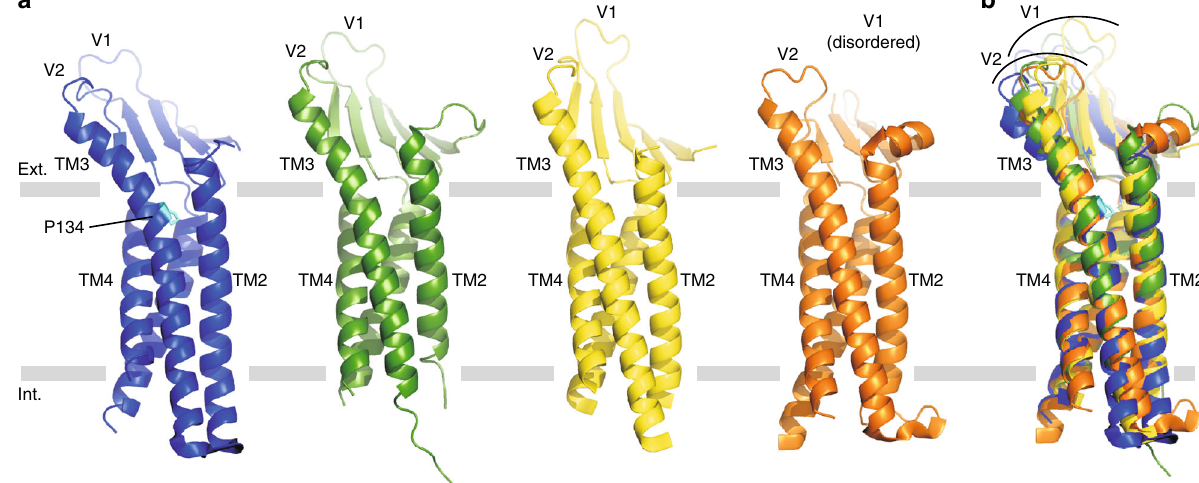
Fig. 2 Comparison with structure-determined subtypes. a Structure-determined Cldn subtypes. mCldn3 cryst , hCldn4, mCldn19, and mCldn15 are colored blue, green, yellow, and orange, respectively. C-CPEs paired with mCldn3 cryst , hCldn4, and mCldn19 are omitted for clear display of the Cldns. Pro134 of mCldn3 is colored cyan. b Superposition of mCldn3 cryst and the other structure-determined